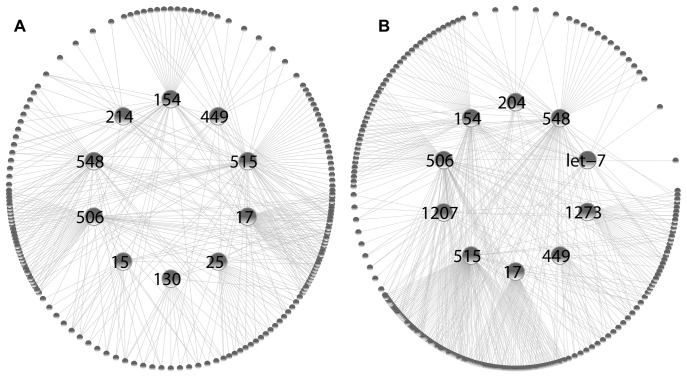
Interaction map between miRNAs and predicted pre- and post- synaptic mRNA targets.A set of ten miRNAs regulated 77% and 80% of pre- and post- synaptic transcripts, respectively. A script was used to identify the combination of miRNAs that were found to interact with the maximum number of synaptic mRNAs. Direct interactions between miRNAs and mRNAs are depicted with grey lines.